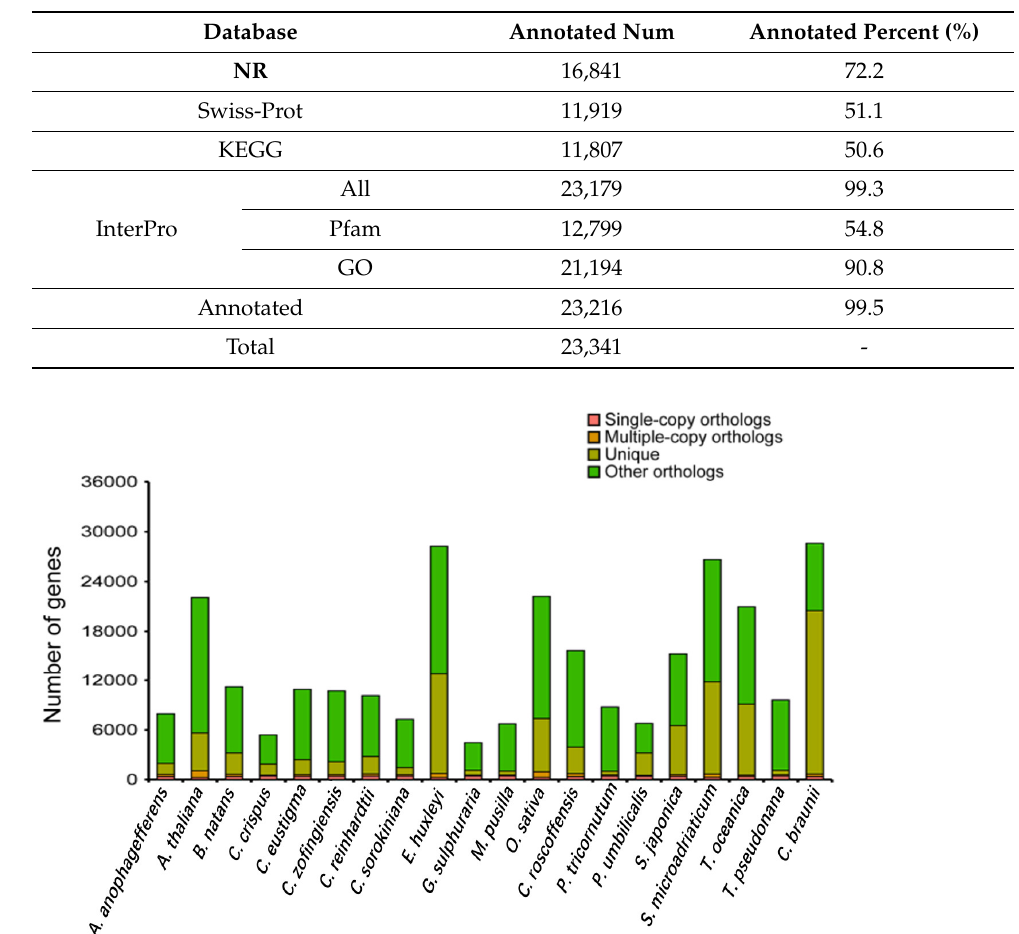
Figure 3. The distribution of genes in Aureococcus anophagefferens , Arabidopsis thaliana , Bigelowiella natans , Chondrus crispus , Chlamydomonas eustigma , Chromochloris zofingiensis , Chlamydomonas rein- hardtii , Chlorella sorokiniana , Emiliania huxleyi , Galdieria sulphuraria , Micromonas pusilla , Oryza sativa , Chrysotila roscoffensis , Phaeodactylum tricornutum , Porphyra umbilicalis , Saccharina japonica , Symbiodinium microadriaticum , Thalassiosira oceanica , Thalassiosira pseudonana and Chara braunii .